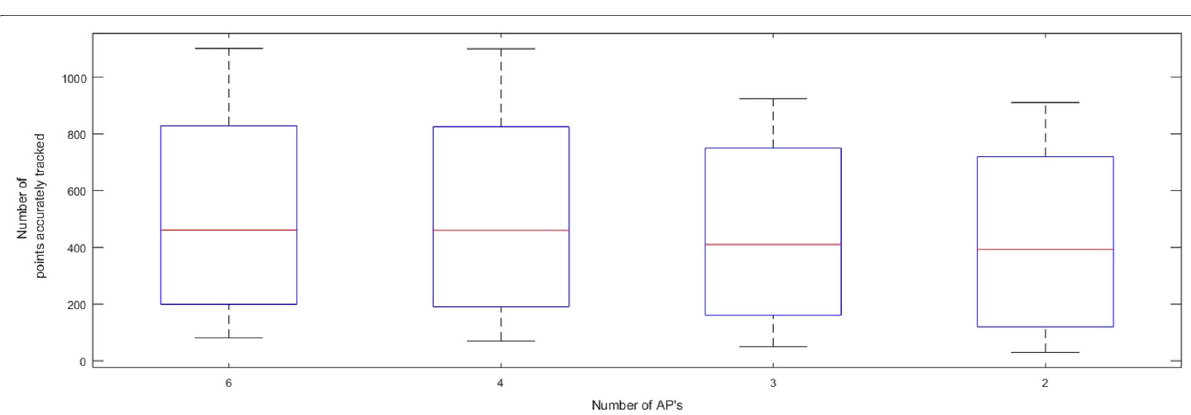
Fig. 8 Box plot showing the deviation in the number of points accurately tracked for different